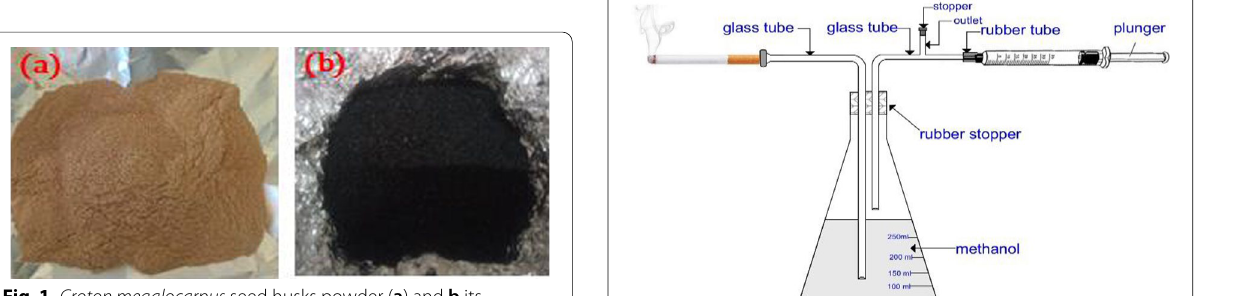
Fig. 1 Croton megalocarpus seed husks powder ( a ) and b its corresponding biochar